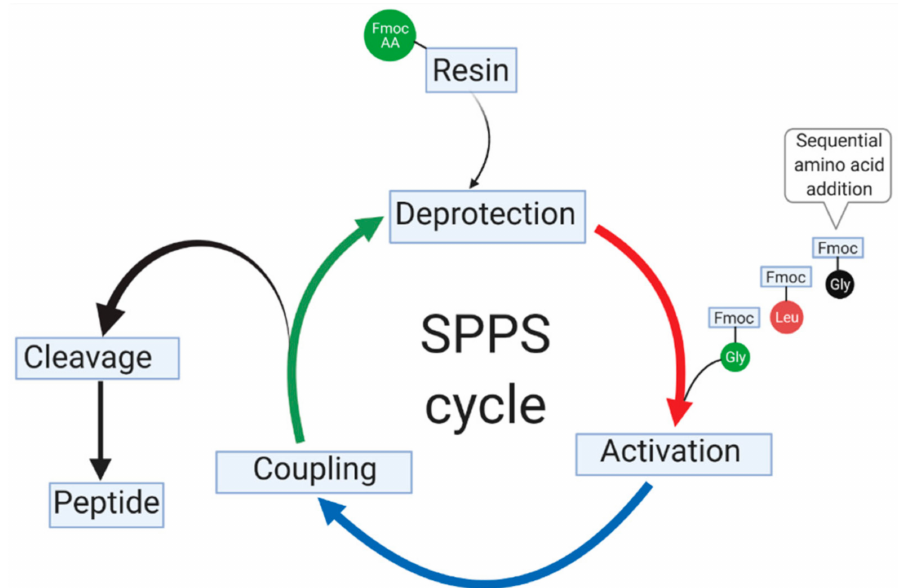
Figure 4. Schematic overview of repeated cycles of Fmoc-based solid-phase peptide synthesis (SPPS). The first cycle shows the attachment of the Fmoc to the resin with a side chain protecting group (top). The protecting group is removed (Fmoc deprotection step), followed by the sequential addition of each amino acid building block (activation step). The subsequent Fmoc-amino acid derivatives are coupled with the appropriate coupling reagents (coupling step). Each completed coupling cycle is followed by deprotection step before proceeding to the cleavage step and finally to the peptide purification. Figure was created with BioRender.com. (Access on 28 February